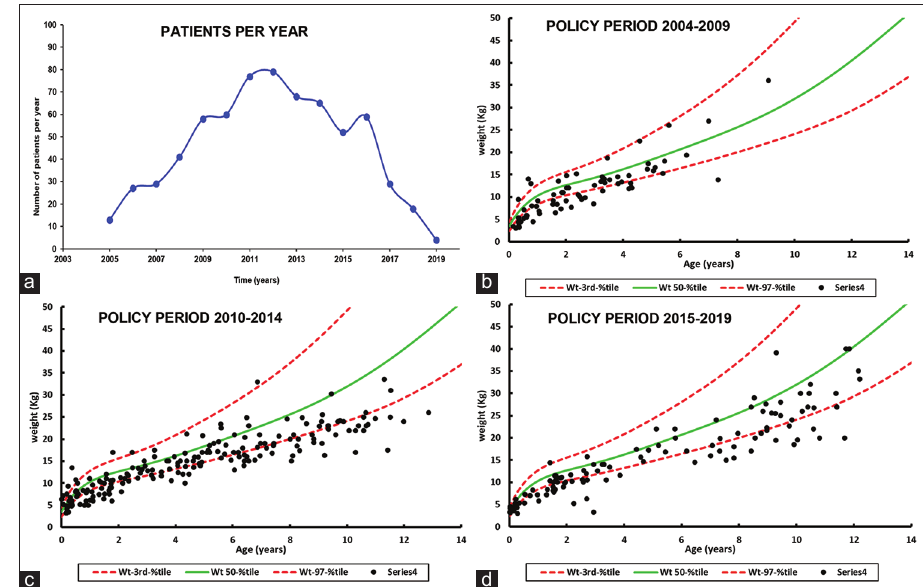
Figure 1: Plots for number of patients initiated on ART per year (a), and growth charts for HIV Children 0 - 13 years correlated with the normal growth percentiles for policy period 2004-2009 (b), 2010-2014 (c) and 2015-2019